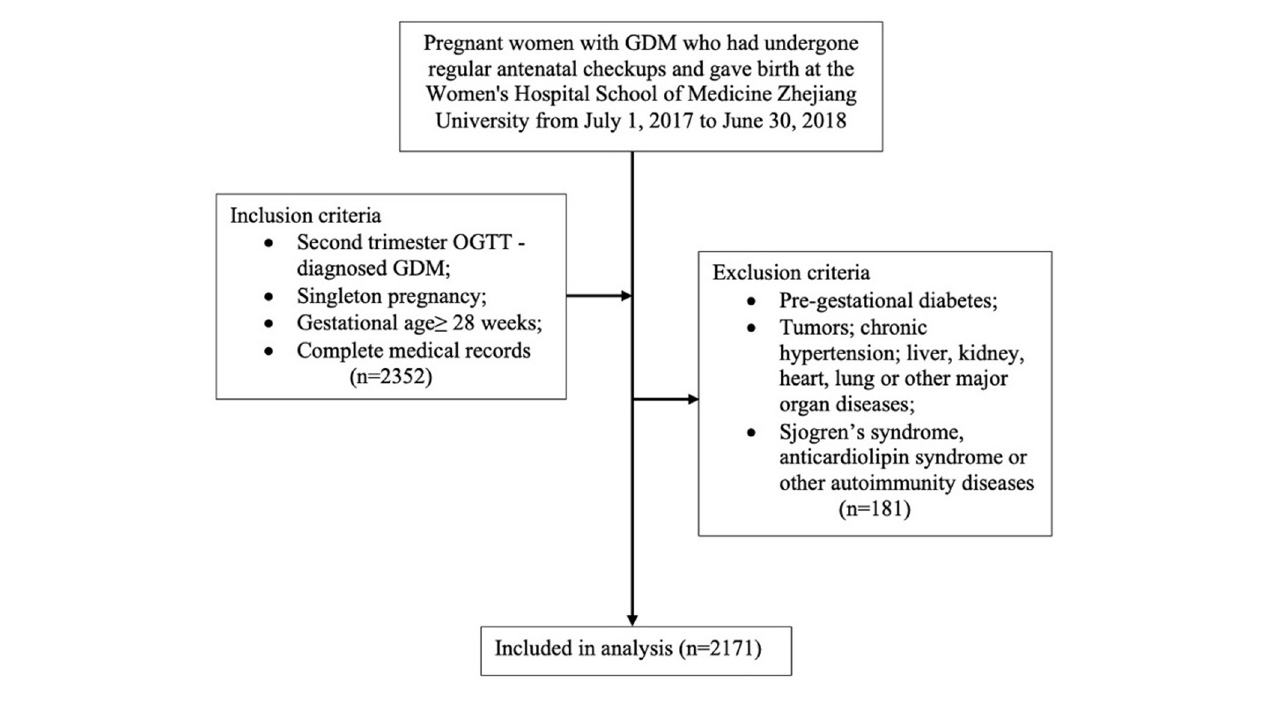
FIGURE 1 | Participant flowchart.